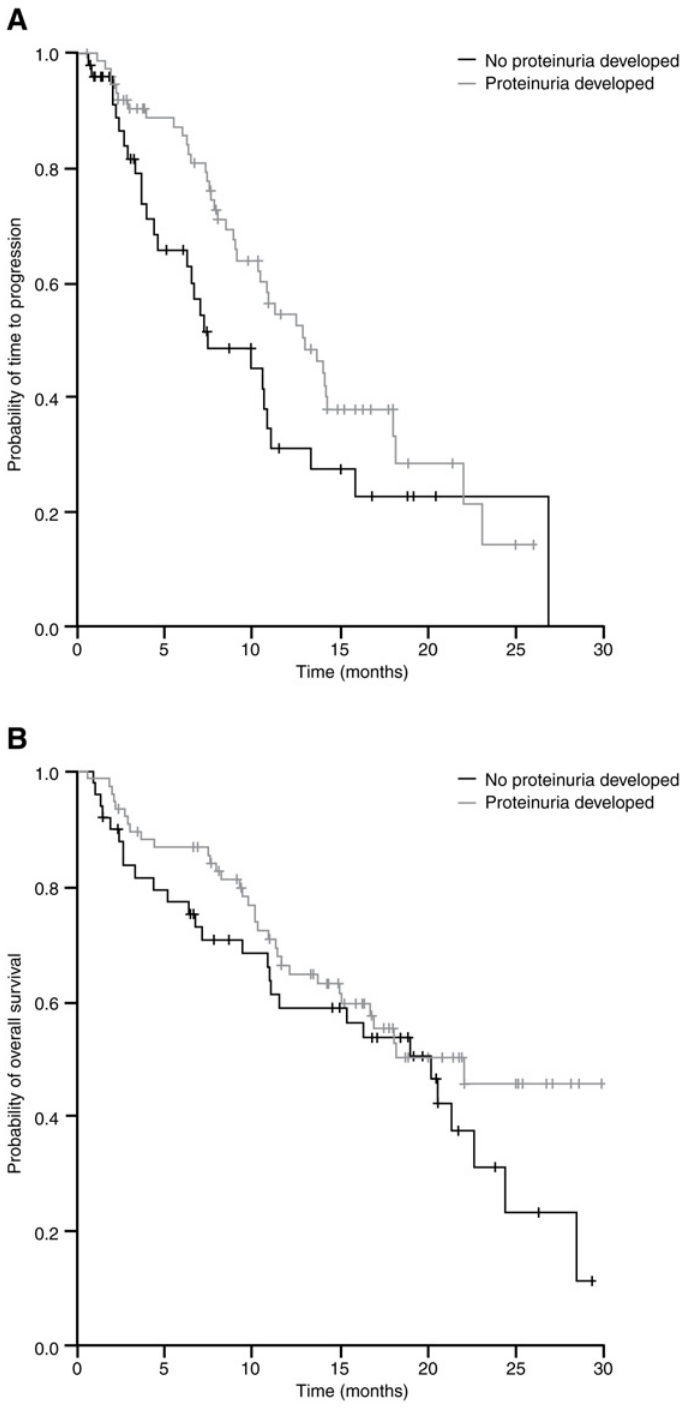
Figure 2. Kaplan – Meier curves of (A) time to progression and (B) overall survival in patients who did and did not develop proteinuria during treatment. Patients who had proteinuria during the study had numerically, but not statistically significantly, greater TTP and OS compared with those patients who did not have proteinuria.